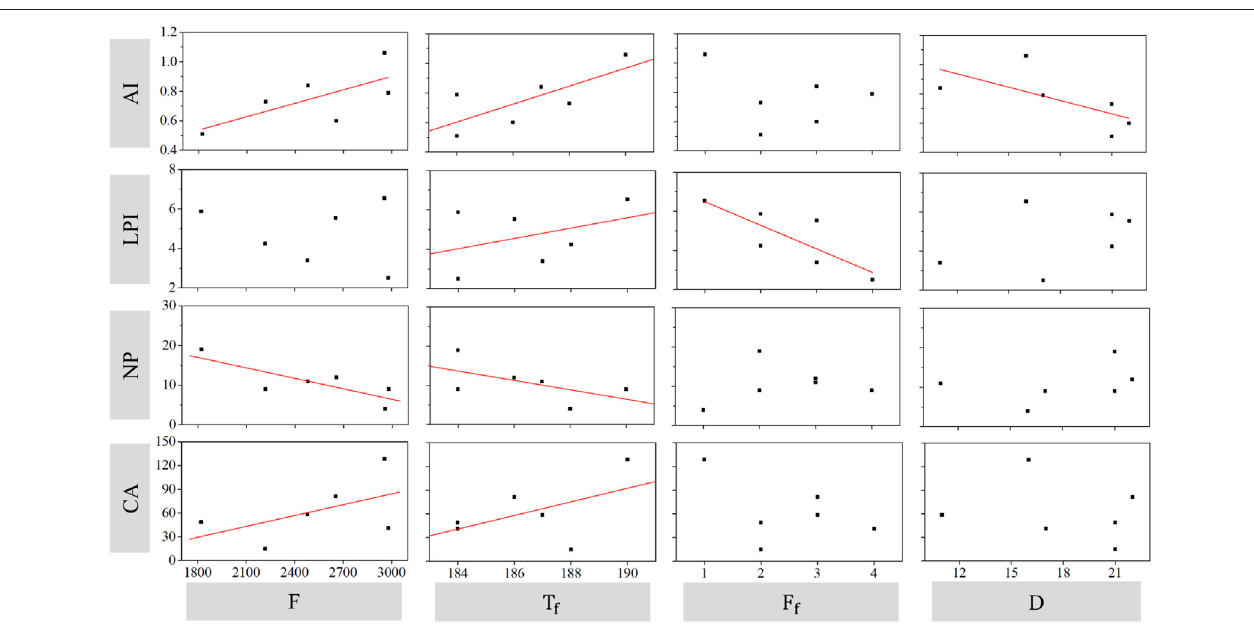
FIGURE 8 | The correlation of fl ow-sediment regime variables with landscape pattern change of S. alterni fl ora. Regression lines were presented when fl ow- sediment regime variables are contained in the optimal GLMs.